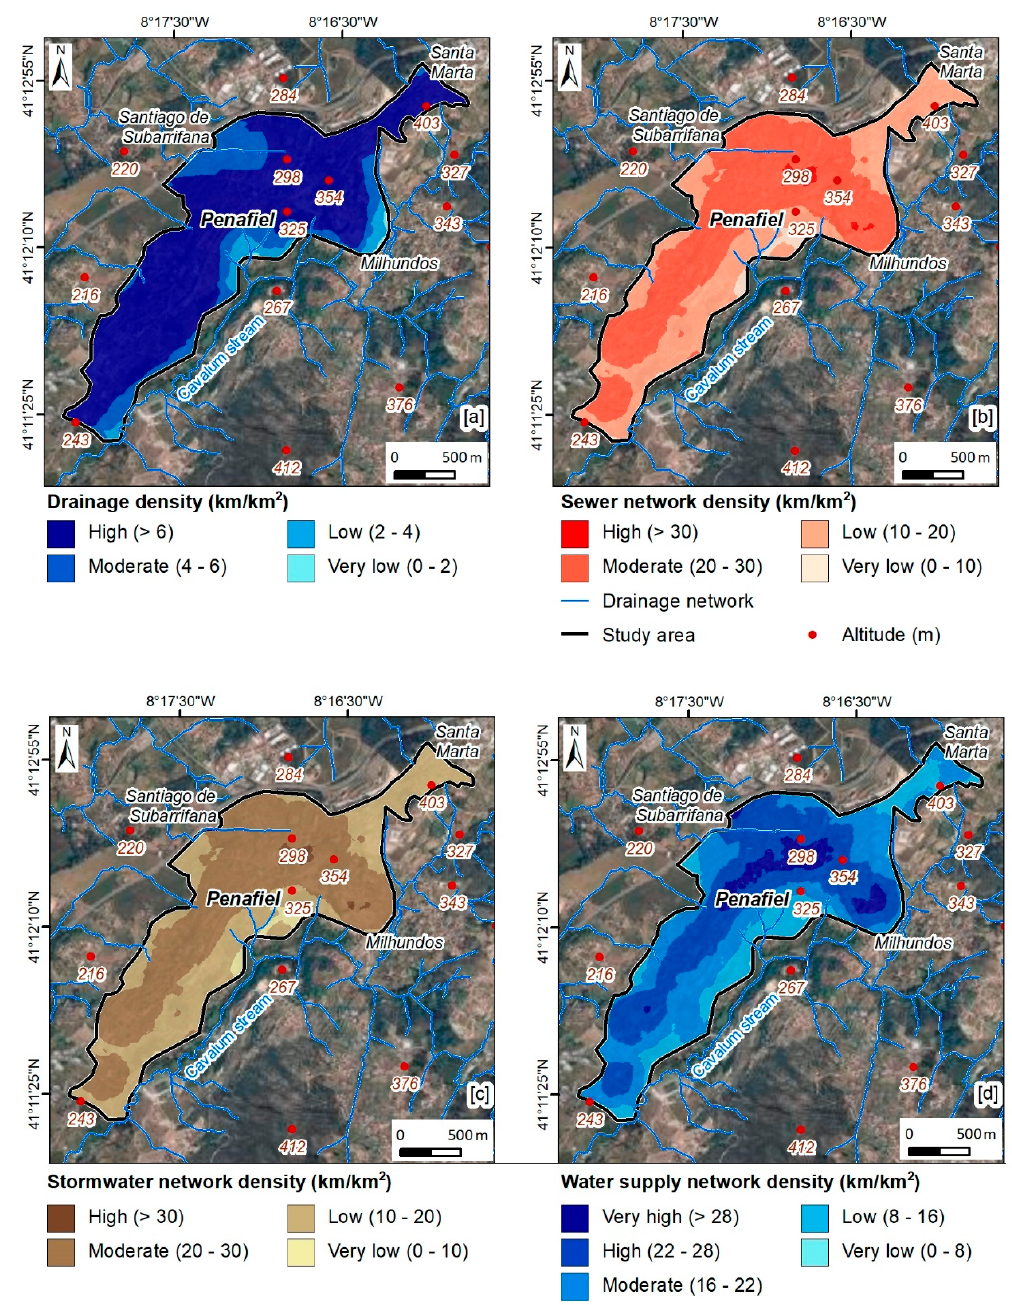
Figure 10. Urban Potential Infiltration Index (IPI-Urban) in the Penafiel urban area (NW Portugal): drainage density ( a ), sewer network density ( b ), stormwater network density ( c ), and water supply network density ( d ).